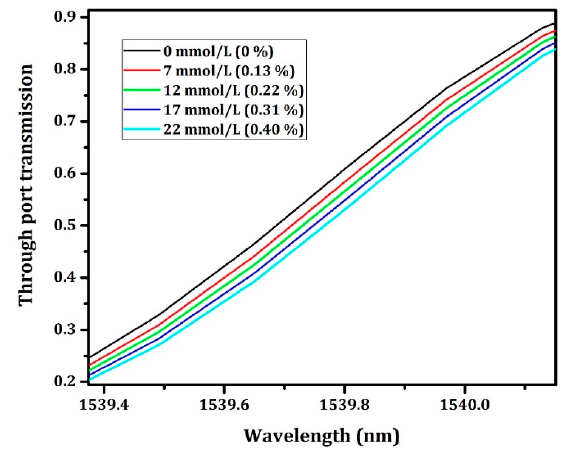
Figure 11. Resonance shift that occurs in MRR-based sensors due to the different glucose concentrations of a diabetic person .